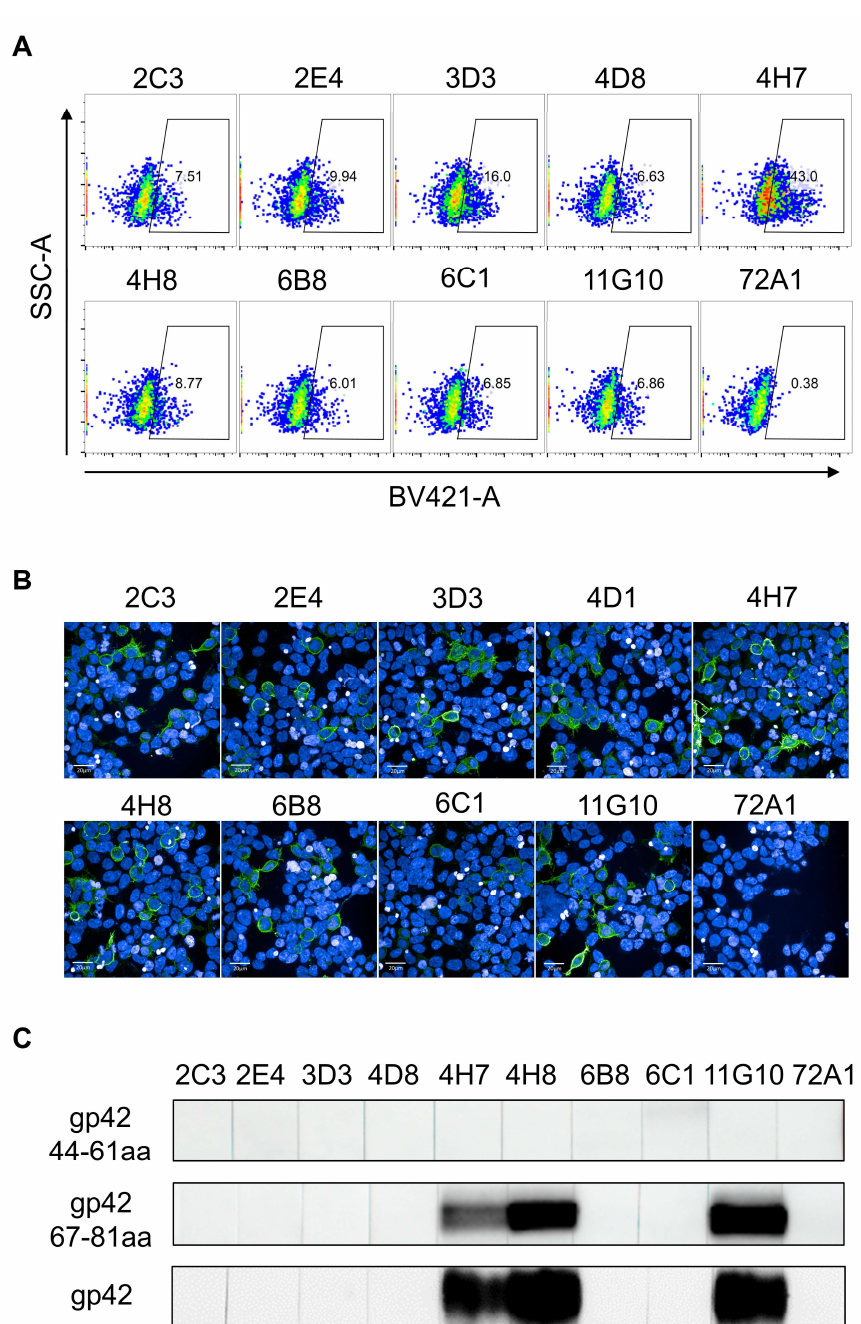
Figure 2. Evaluation of binding activities of 9 mAbs. ( A , B ) Detection of gp42 on the surface of full-length gp42 transfected 293T cells using ( A ) fluorescence activated cell sorting (FACS) and ( B ) immunofluorescence (IF) assays. Antibodies were labeled with ( A ) GAM-BV421 and ( B ) GAM-Alexa-Fluor 488. Anti-gp350 murine antibody 72A1 was used as negative control. ( C ) In total, 9 mAbs were tested by Western blot for reactivity against denatured GST-fused gp42-44-61aa, GST-fused gp42-67-81aa and gp42 proteins.